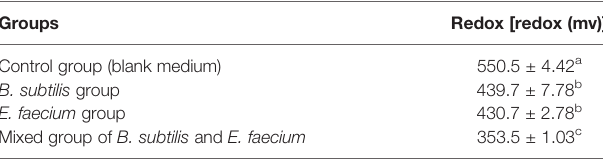
TABLE 2 | Change of redox potential after culture of Bacillus subtilis and Enterococcus faecium alone and in combination. Groups